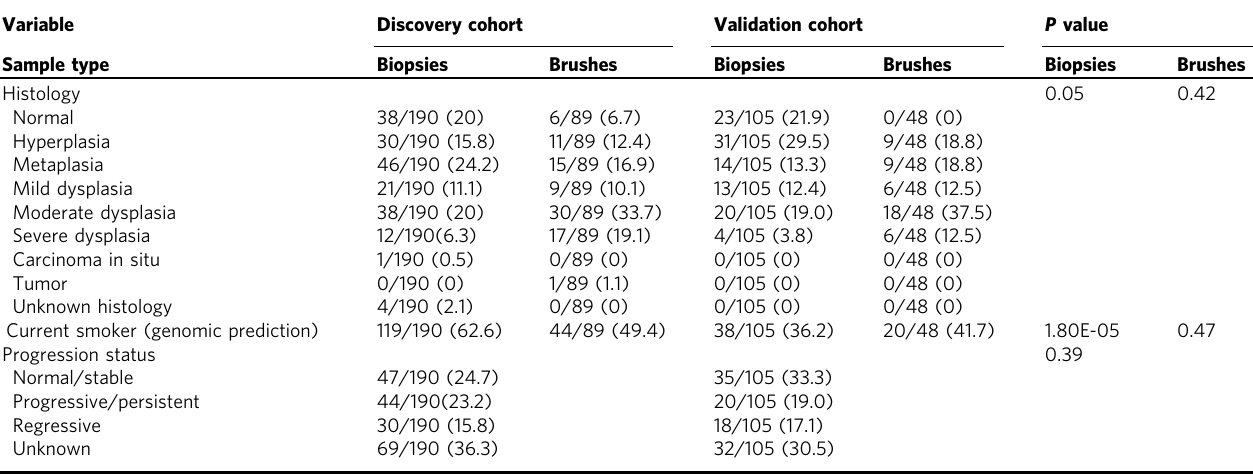
Table 2 Sample clinical annotation in the discovery and validation cohorts